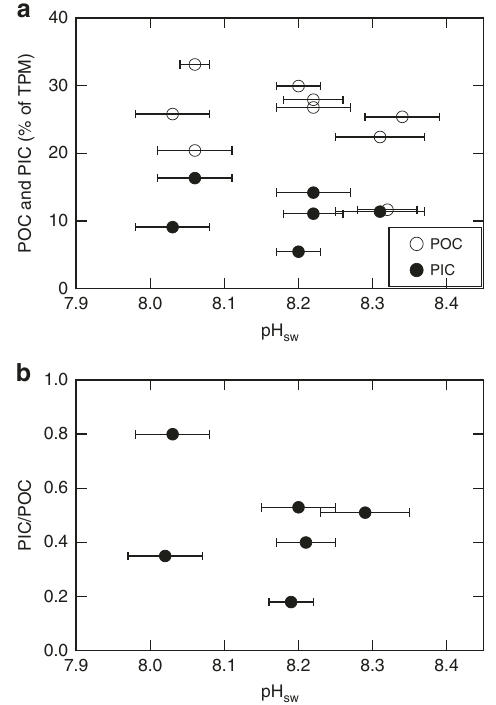
Fig. 6 PIC, POC, and PIC/POC of O. neapolitana for varying pH SW . Seawater pH vs. particulate inorganic carbon (PIC) content as weight percent of total particulate matter (TPM) (solid circle, a ), particulate organic carbon (POC) content as weight percent of TPM (open circle, a ), and PIC/POC ratio ( b ). Error bars are 1